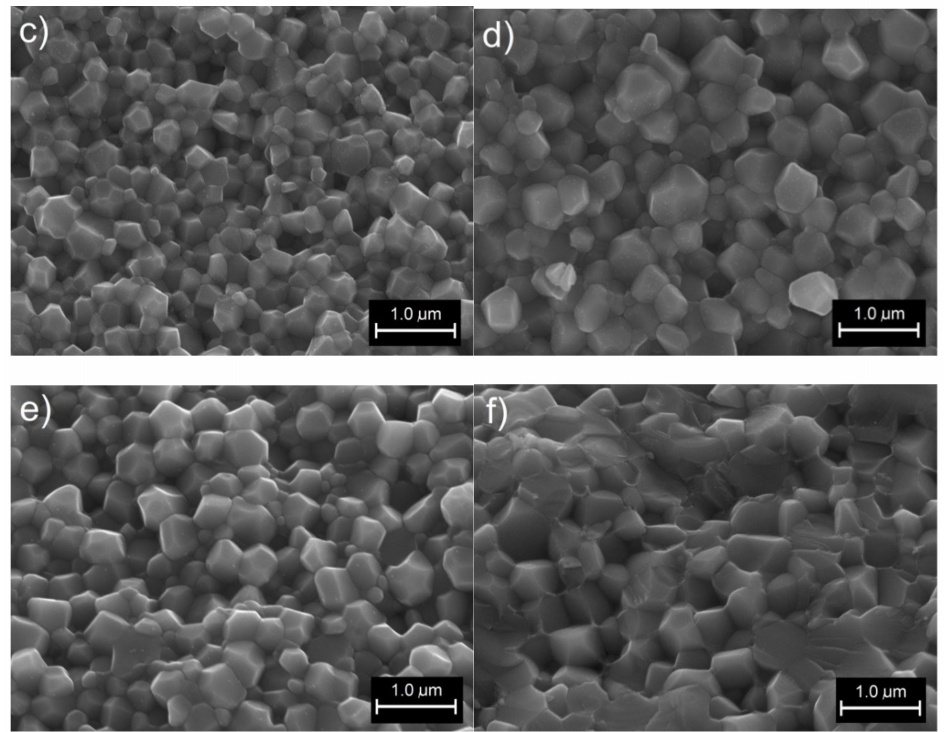
Figure 2. Scanning Electron Microscopy (SEM) images of the microstructure of fracture of the BFN x MA ceramic samples: BFN 10 MA ( a ), BFN 20 MA ( b ), BFN 40 MA ( c ), BFN 60 MA ( d ), BFN 75 MA ( e ), and BFN 100 MA ( f ) (magnification ×